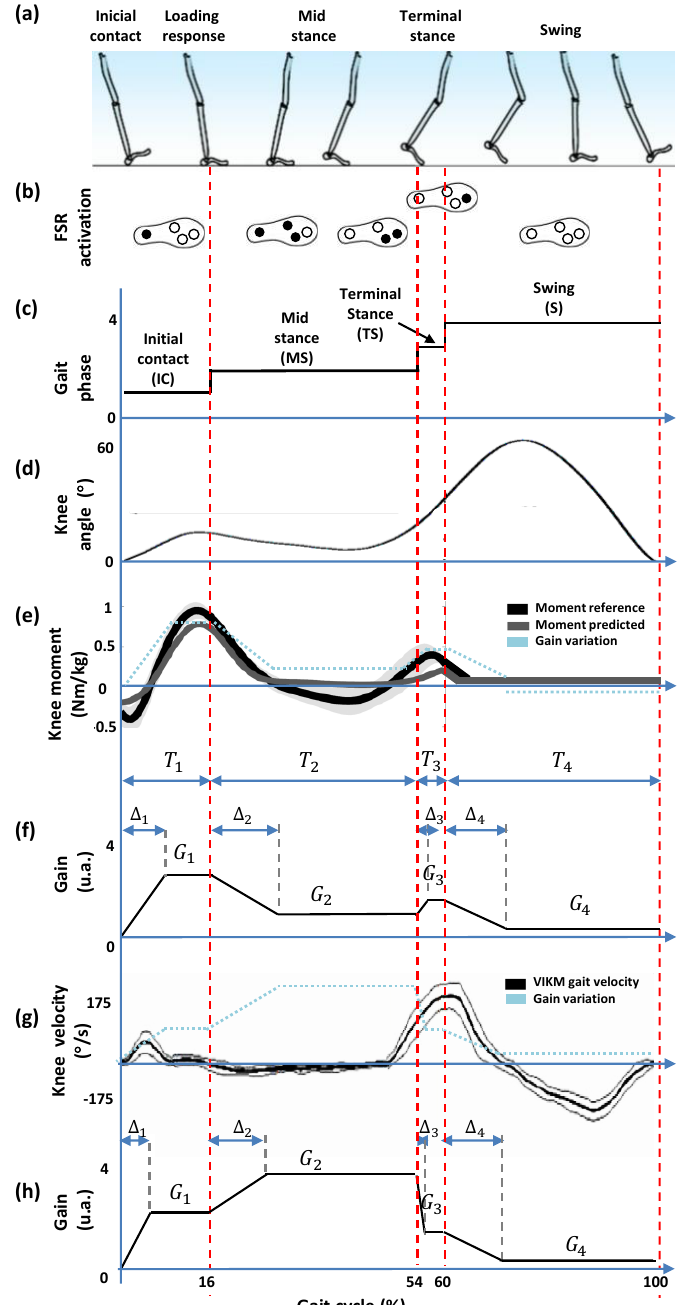
Figure 2. Events related to gait phases. ( a ) sub-phases of the gait cycle; ( b ) on-off sequence of force sensing resistors (FSR) throughout the gait cycle; ( c ) footswitch signal generated by the instrumented insole to identify gait phases; ( d ) knee angle throughout the gait cycle; ( e ) knee moment during gait, correspondent to the reference and predicted values of [21]; the gain variation was considered to define the gait pattern to knee impedance modulation during gait; ( f ) gain pattern P 1 based on the knee moment to decrease/increase gain values during gait phases for stance control; ( g ) knee velocity during gait using the variable impedance knee mechanism (VIKM) [38]; ( h ) gain pattern P 2 based on the the knee velocity to decrease/increase gain values during gait phases for a stance